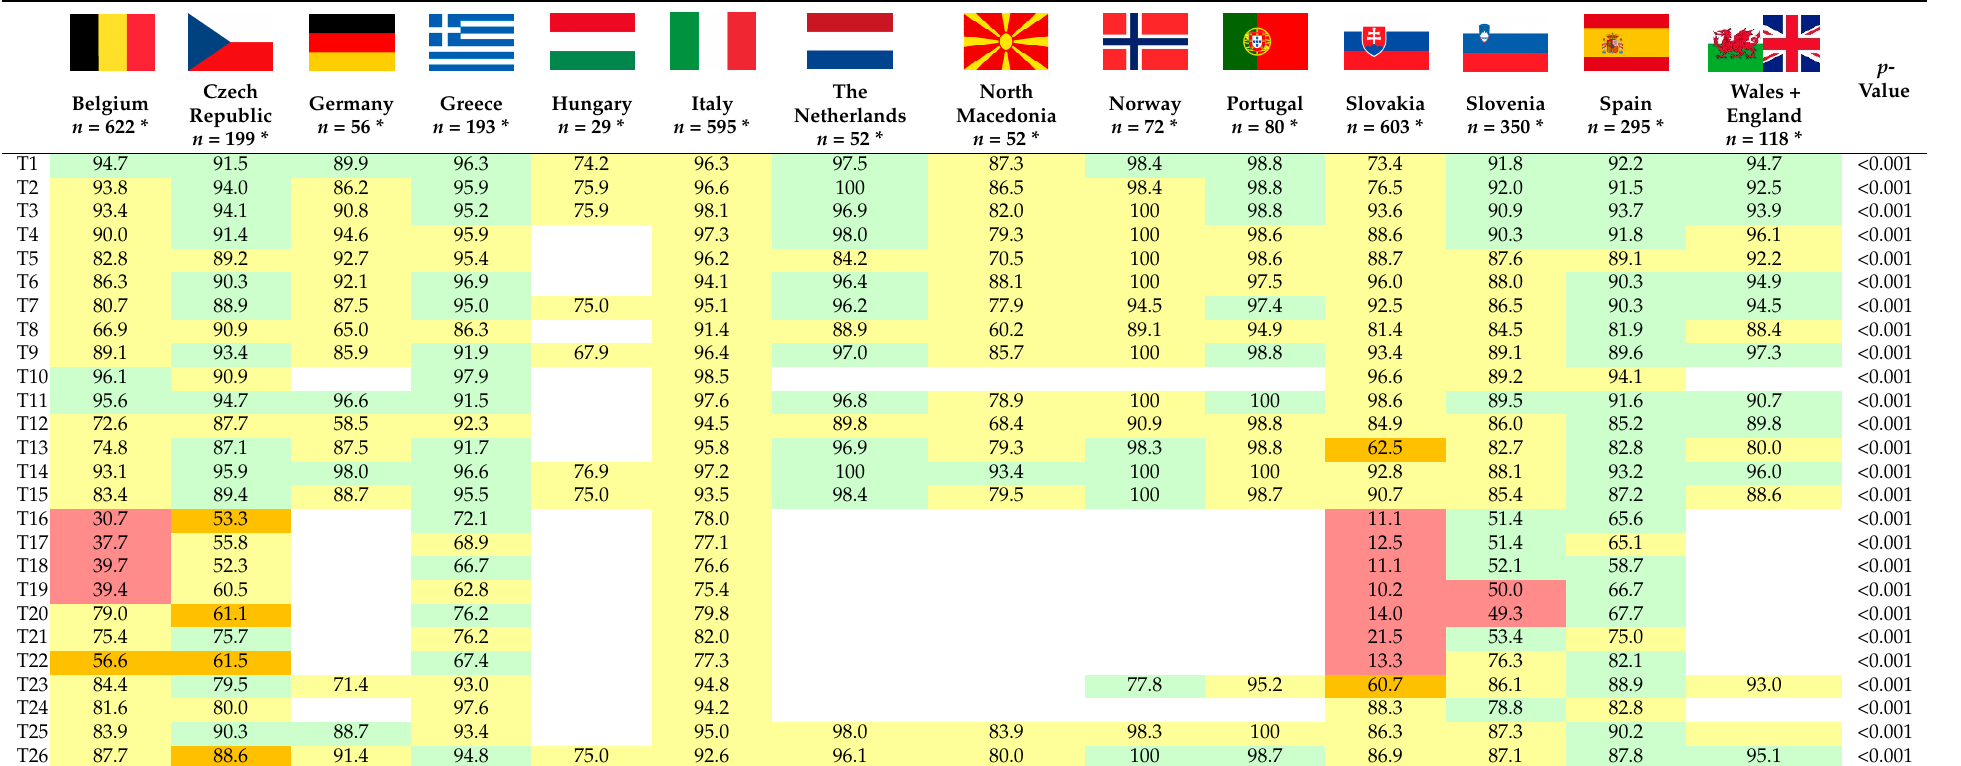
Table 4 . Percentages of healthcare professionals considering 26 tasks in seven $ pharmaceutical care domains to be nurses’ tasks in order to obtain best quality of care and patient outcomes, split up for 14 countries.